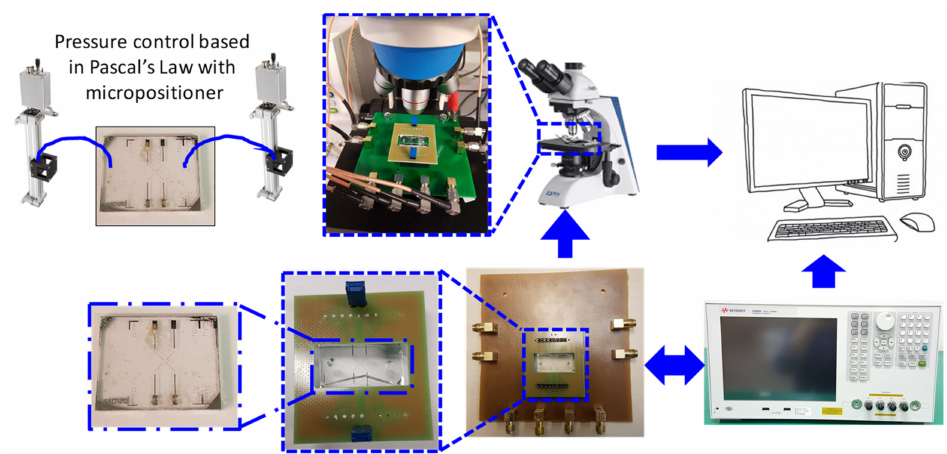
Figure A2. Schematic of the measurement setup composed of a micropositioner, a microscope with a CMOS camera, a Keysight E4990A impedance analyzer (Keysight Technologies, Santa Rosa, CA, USA), and a computer.